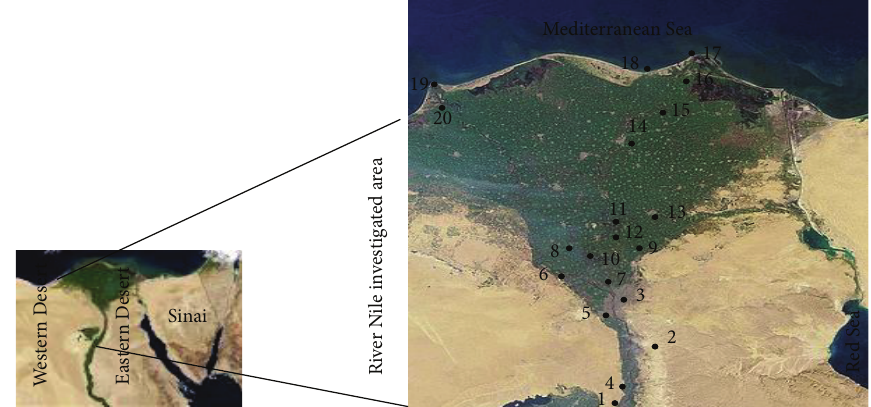
Figure 1: Map of the River Nile showing sites of water sampling: Greater Cairo; 1. Alwasta-Beni Sweif, 2. Helwan, 3. Cairo, 4. Alaeat-Giza, 5. Giza town, 6. Alknater-Giza, 7. Qalubiya and Nile Delta; 8. Monofeya, 9. Belbas, 10. Benha, 11. Alazezea-Menia El Kamh, 12. Menia El Kamh town, 13. Zagazig, 14. Mansoura and Nile estuaries; 15. Fraskour-Damietta, 16. Damietta town, 17. Ras El-bar, 18. Gamasa, 19. Rosetta town, 20. Edfina-Rosetta.